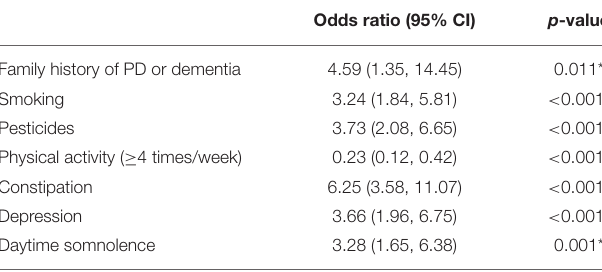
TABLE 2 | Parameters selected for multivariate logistic regression models for predicting possible REM sleep behavior disorder